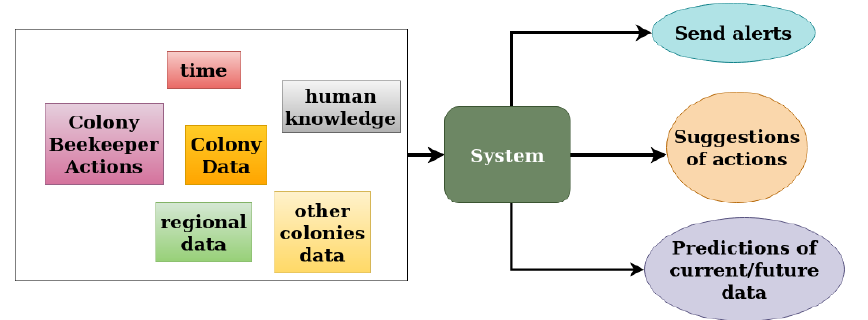
Figure 14. System data and information.